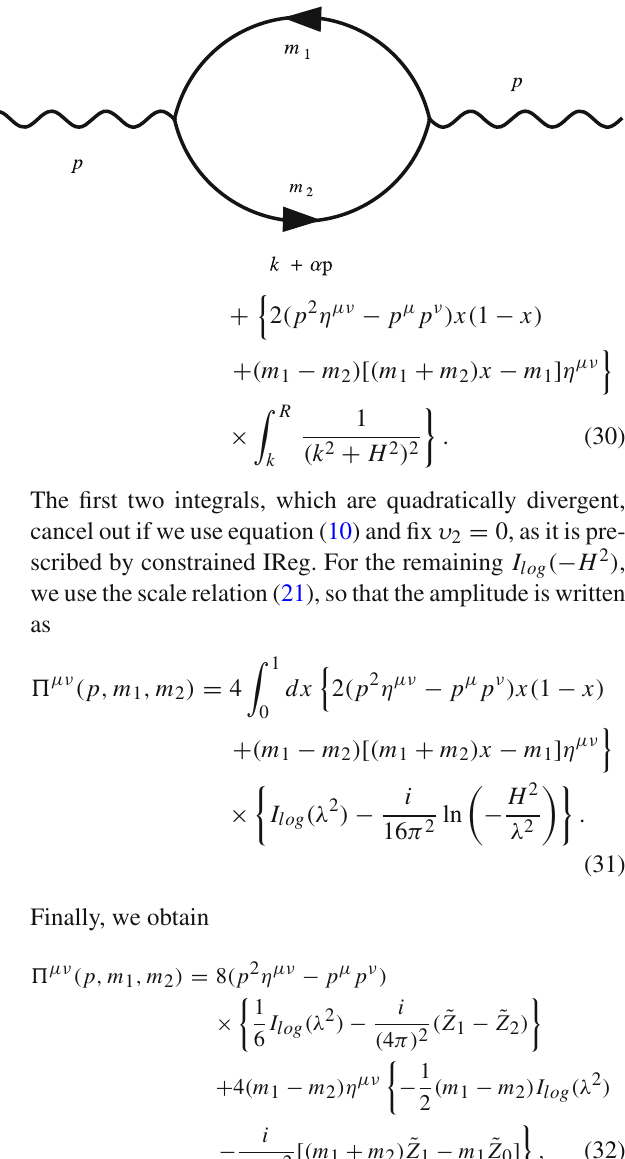
Fig. 1 Diagram which contributes to the self-energy of a massive vector-field. The fermionic fields in the loop have different masses and the momentum routing in the amplitude reads k + (α − 1 ) p for the propagator with mass m 1 and k + α p for the propagator with mass m 2 . The wavy and solid lines represent the vectorial and fermionic fields,